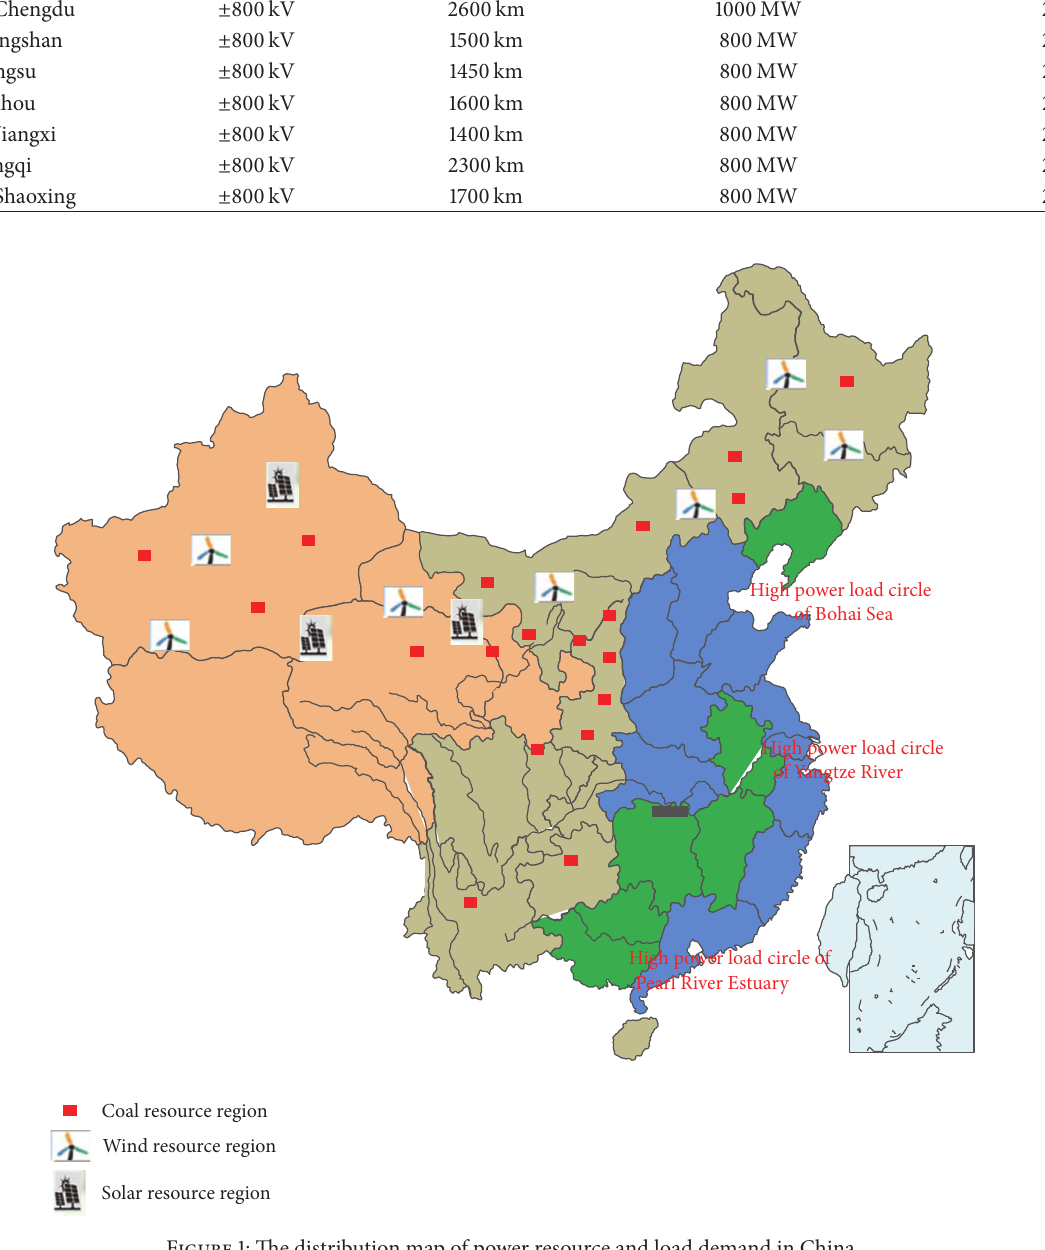
Figure 1: The distribution map of power resource and load demand in